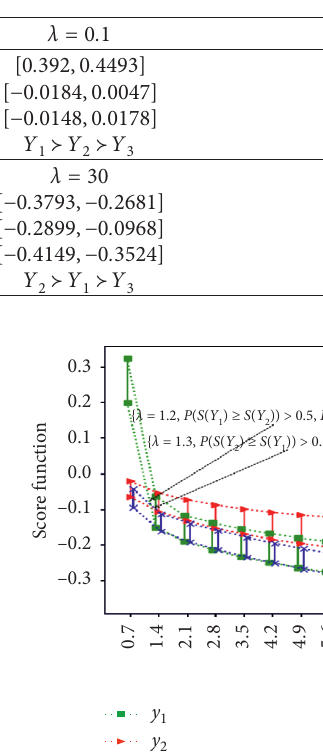
Figure 1: Variation of the score functions of the GIVPHFHA operators by the parameter λ . Table 9: Score values based on the GIVPHFHG operators.